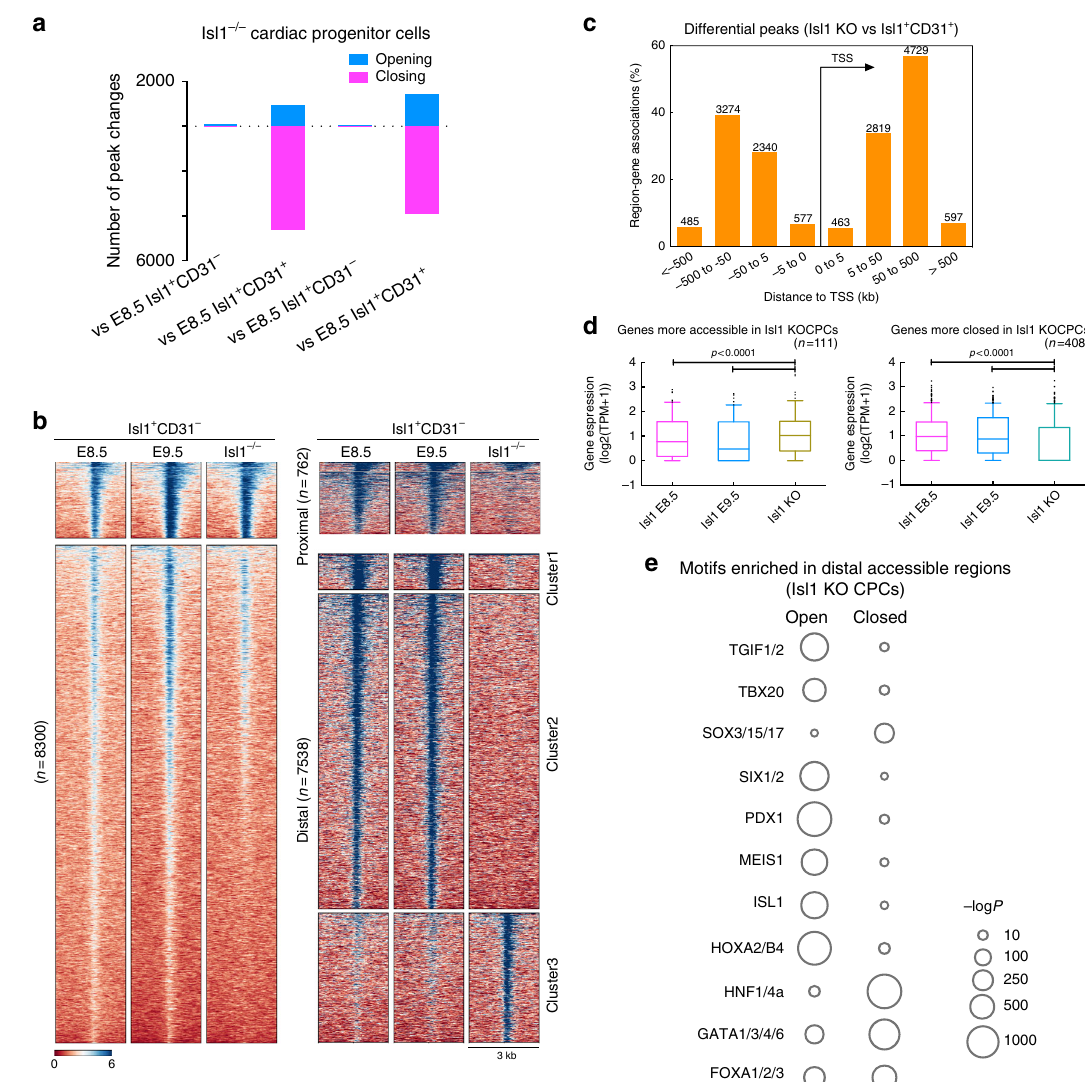
Fig. 9 Chromatin accessibility in CPCs is shaped by Isl1. a Number of differential chromatin accessibility peaks (log2(FC) > 2, false discovery rate [FDR] < 0.05). b Genome-wide distribution of differential open chromatin peaks grouped by K -means (left), and by distance to promoter and K -means (right). Each row represents one differential peak, normalized to sequencing depth, in sequential comparisons (log2[FC] > 2, FDR < 0.05). c Number of differential peaks and their distance to the nearest promoters. d Boxplots of mRNA expression levels in E8.5 and 9.5 Isl1 + CPCs, and of genes that are more accessible (left) or more closed (right) in Isl1 KO cells. Box lines show the median, 25th and 75th percentiles; whiskers represent 5th and 95th percentiles; dots represent outlier data points. p- values were calculated using Student ’ s t -test. n indicates the genes numbers. e Bubble chart showing the enrichment of transcription factor motifs in differential peaks ( p -values were calculated from the hypergeometric